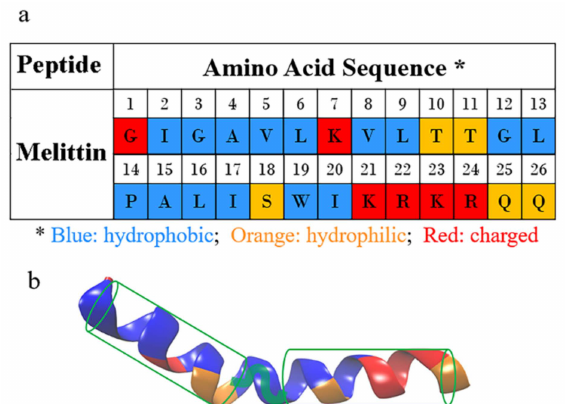
Figure 1. Structure of melittin. ( a ) The amino acid sequence of melittin. Di ff erent types of residues are colored di ff erently: blue for hydrophobic residues, orange for hydrophilic ones, and red for charged ones; ( b ) the secondary structure of melittin showing the amphipathic α -helical configuration (when binding on a membrane). The two α -helixes of melittin are sketched with green cylinders, being connected with the kink part between them. Corresponding amino acid residues are highlighted with the same color scheme as in ( a